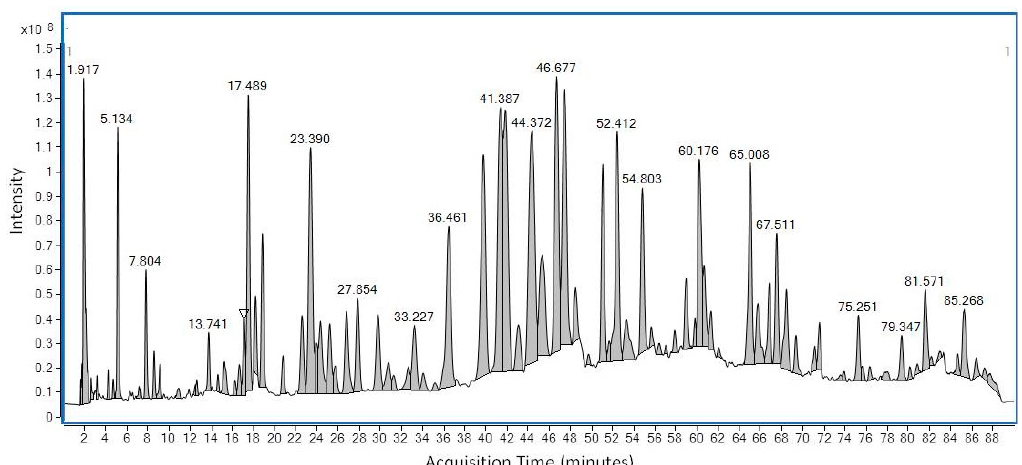
Figure 1. LC-MS chromatogram of Spanish Ethanolic Extract of Propolis (SEEP) showing the major and minor organic peaks found in the sample.